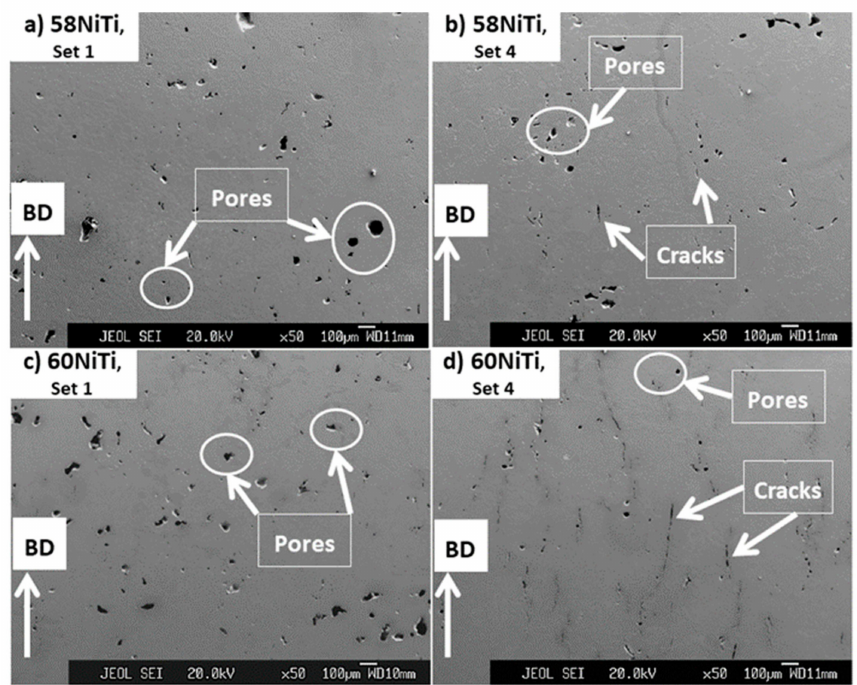
Figure 12. Images obtained from the cross-section of secondary HIP-treated ( a , b ) 58NiTi and ( c , d ) 60NiTi samples processed from parts printed by sets 1 and 4, having energy inputs of 27.70 and 39.68 J/mm 3 , respectively. The secondary HIP treatments for 60NiTi parts were conducted at 1165 ◦ C and for 58NiTi ones printed by sets 1 and 4 at 1175 ◦ C and 1170 ◦ C, respectively. Some of the cracks and pores seen in the microstructure of these samples are shown in the images. Table 5. Average relative densities and apparent hardness values of 58NiTi and 60NiTi parts processed by elementary HIP treatments from parts printed by sets 1 and 4. Average relative densities and apparent hardness values of secondary HIP-treated parts and hardened ones are also reported in this